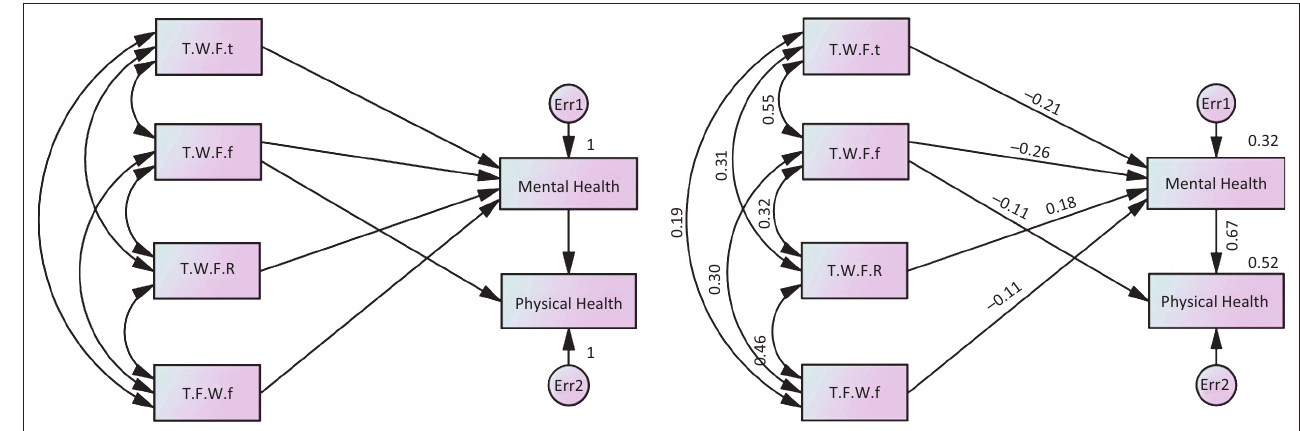
FIGURE 4: Final model of the relationship between the research variables.